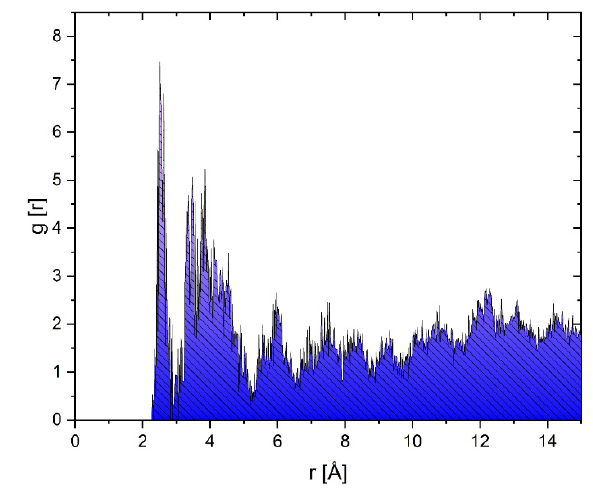
Figure 13. RDF of nitrogen MV the halloysite surface obtained via MD.